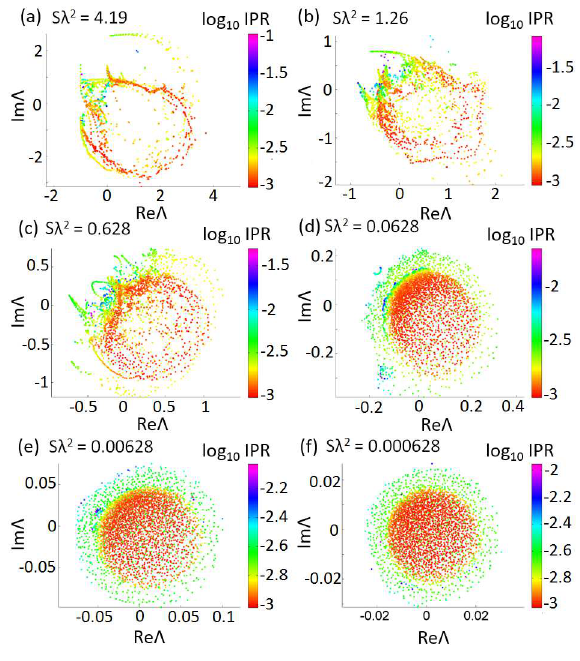
Figure 10. Eigenvalue distributions of the dyadic Green’s matrix in the complex plane for N = 1000 µ -spiral array with ( a ) S λ 2 = 4.19; ( b ) S λ 2 = 1.26; ( c ) S λ 2 = 0.628; ( d ) S λ 2 = 0.0628; ( e ) S λ 2 = 0.00628; ( f ) S λ 2 = 0.000628. The color bar shows the inverse participation ratio (IPR) of the eigenmode associated to each eigenvalue in log